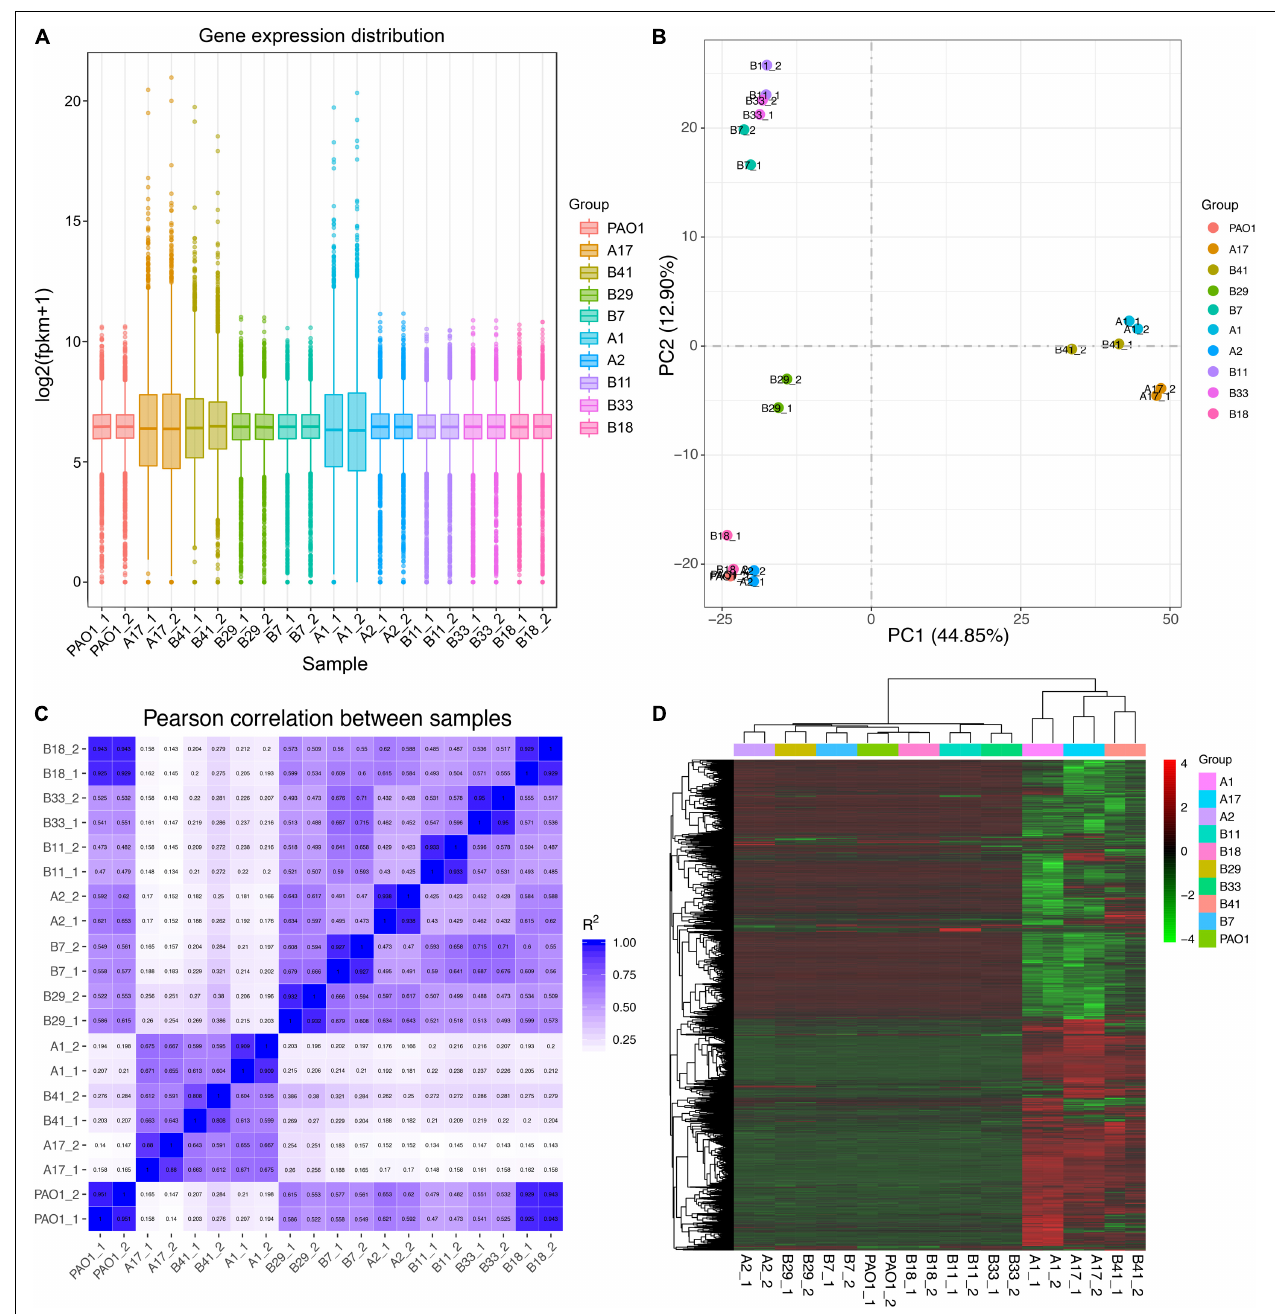
FIGURE 4 | General transcriptional patterns of P. aeruginosa COPD isolates based on RNA-seq-determined gene expression values (FPKM). (A) Distribution of gene expression in each P. aeruginosa isolate and their independent replicates. (B) Transcriptional pattern-based relationship among P. aeruginosa COPD isolates as determined by PCA. (C) Transcriptional pattern-based Pearson correlation between P. aeruginosa COPD isolates. (D) Single gene expression level-based general correlation among P. aeruginosa COPD